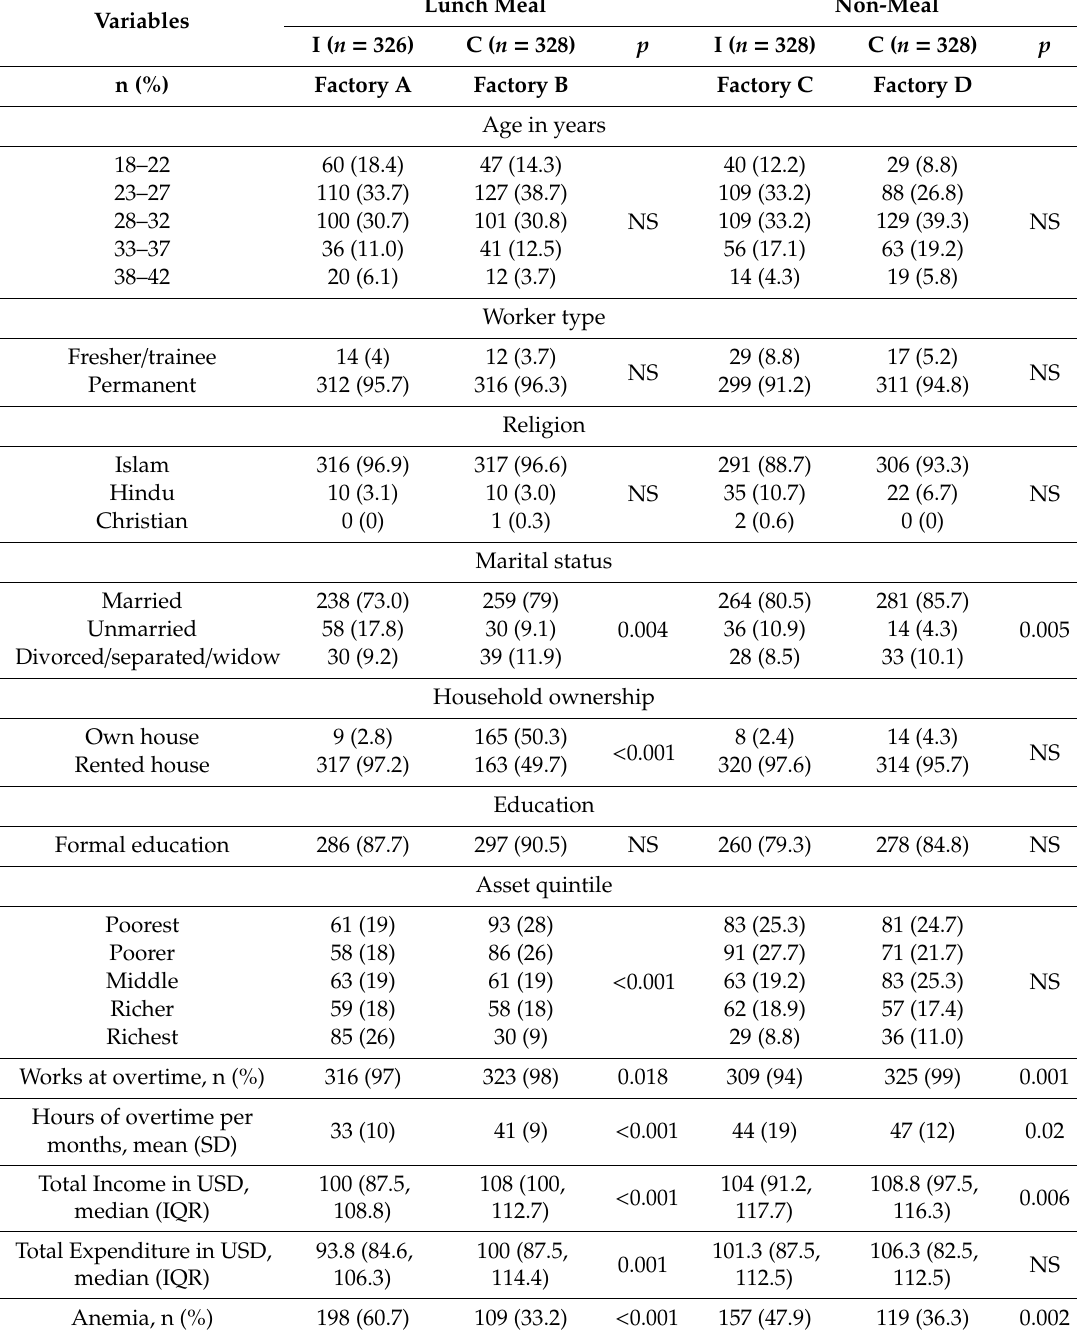
Table 2. Baseline socio-demographic characteristics of the participants from four readymade garment